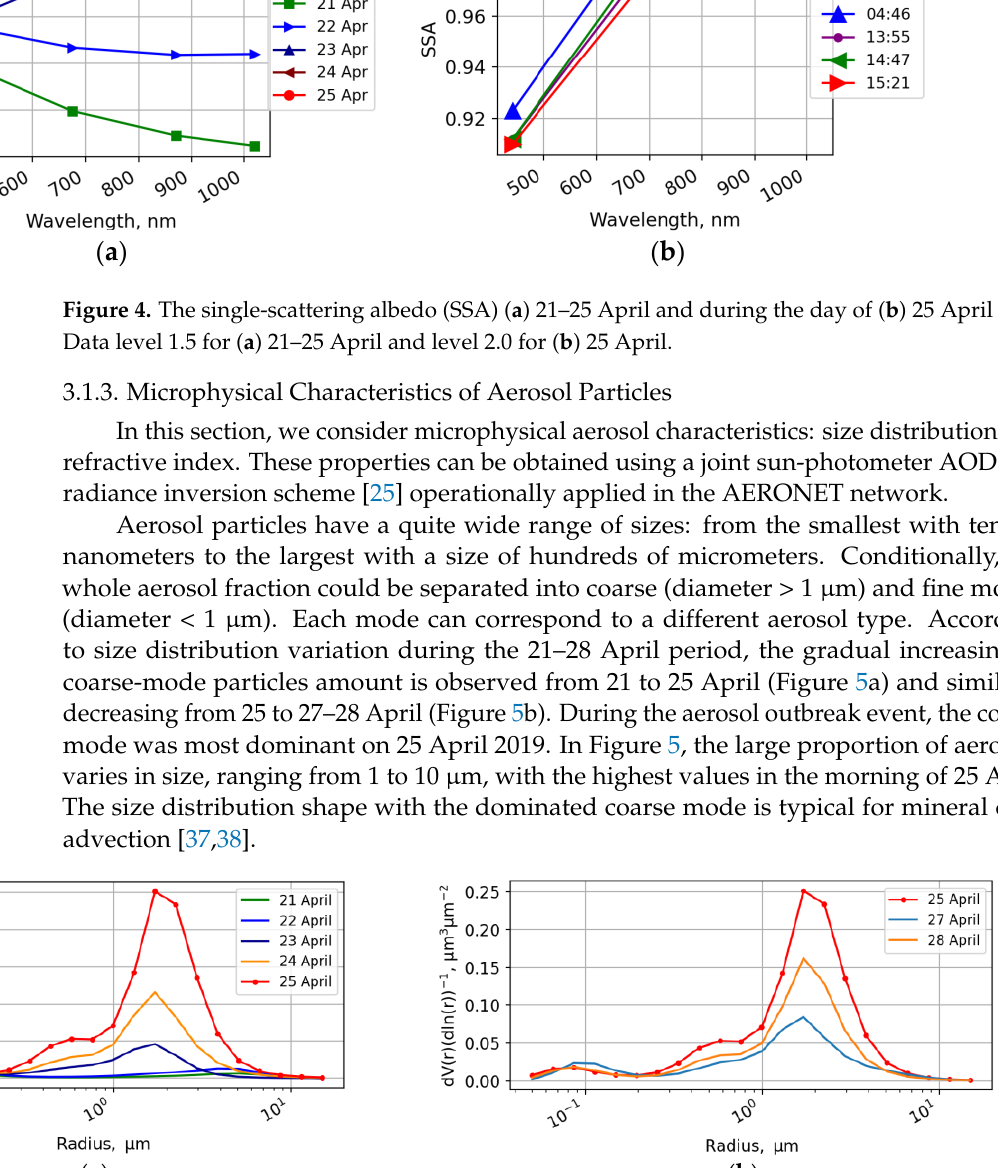
Figure 5. Aerosol volume size distribution on ( a ) 21 – 25 April and ( b ) 25 – 28 April 2019. Data level 2.0. Data on 26 April are not available.